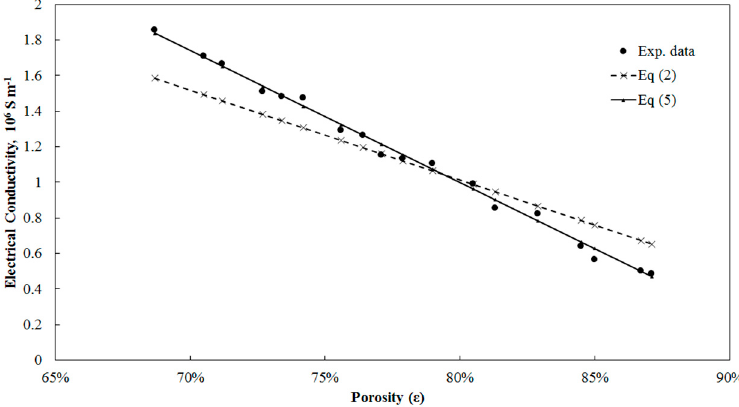
Figure 4. Prediction of experimental data from Feng et al. [30] by Equation (2) and its modified version, Equation (5).